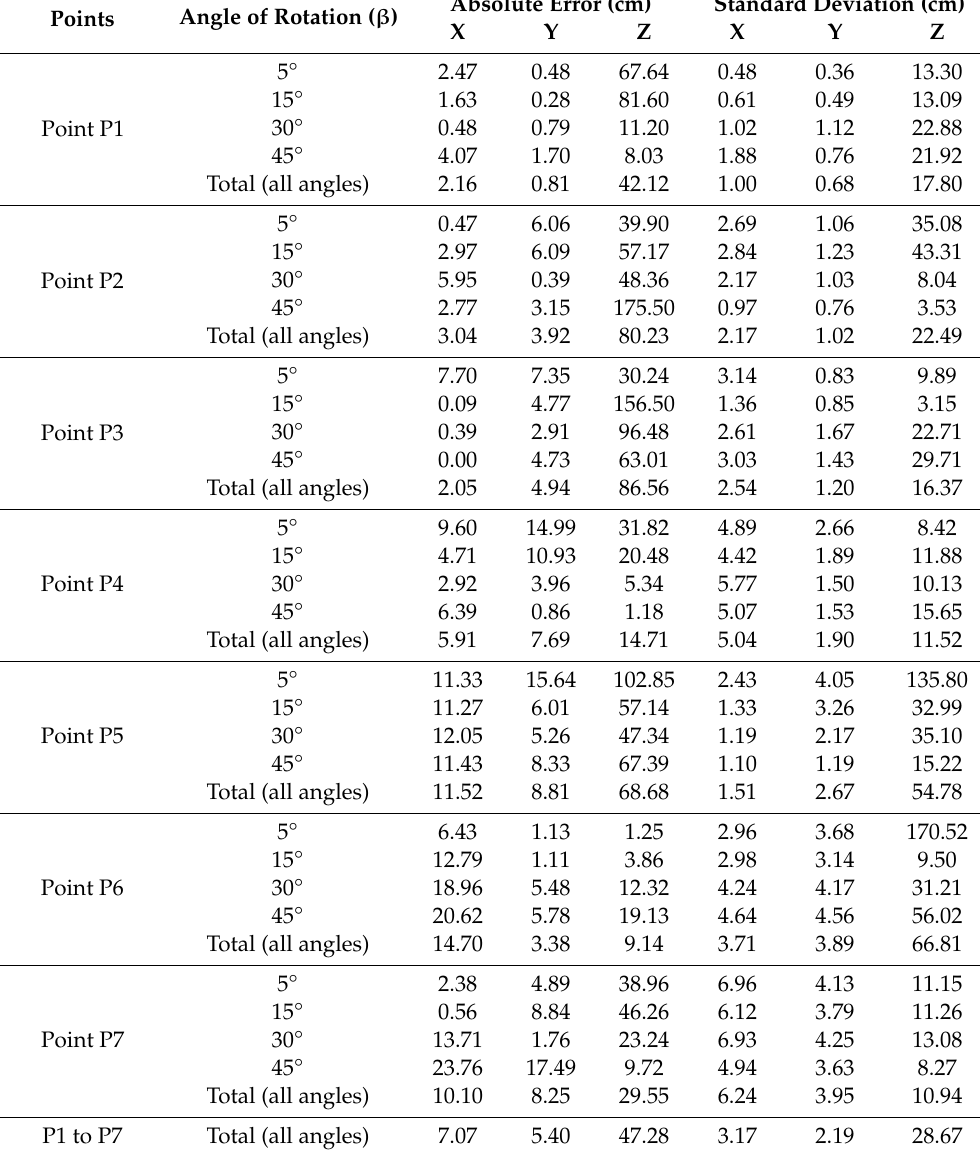
Table 1. Absolute average and standard deviation errors, at each coordinate, for the real results obtained in the analyzed points P1 to P7. Absolute Error Points Angle of Rotation ( β )